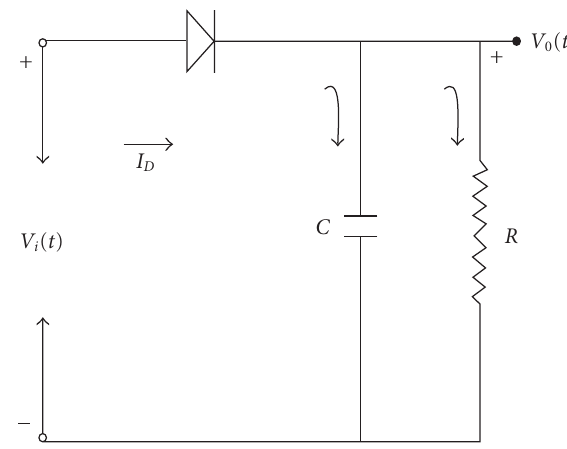
Figure 1.1. Half-wave rectifier circuit with capacitive